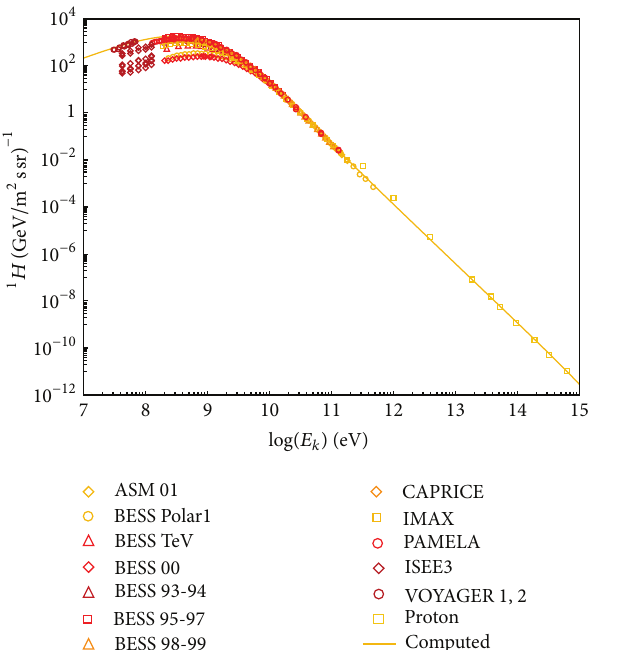
Figure 6: Features in the low-energy end of the spectrum are enhanced when proton flux 𝐹 is divided by energy 𝐸 𝑘 . The figure is compiled from many measurements that are available from Database of Charged Cosmic Rays [79] (see text for references). The computed line (orange line) has been scaled in energy to match the data to reveal that the low-energy end of flux originates mostly from rapidly receding sources in the expanding part of the